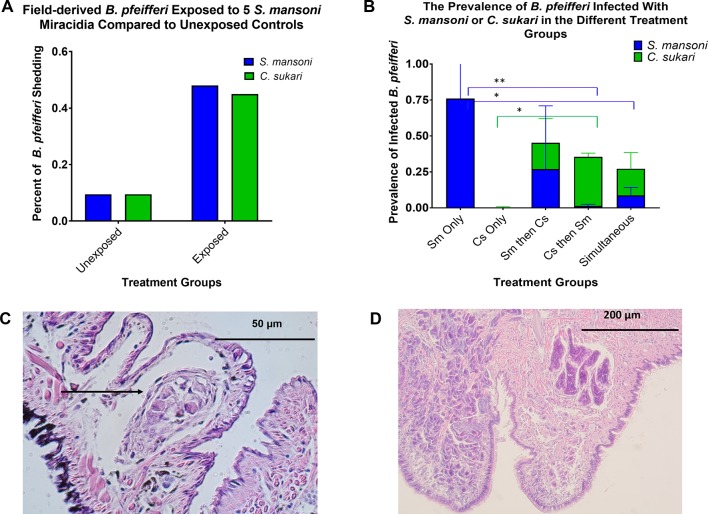
Human and cattle parasite interactions at Asao Stream.(A) Field-derived B. pfeifferi shown not to be shedding any cercariae at the time of collection were either left as unexposed controls or were exposed to S. mansoni (five miracidia/snail). Note that, unexpectedly, exposed snails were just as likely to subsequently shed C. sukari as S. mansoni cercariae compared to the control groups (p=<0.001). A few unexposed snails also shed cercariae, indicating that some of the snails had prepatent snails at the time of infection. (B) The prevalence of lab-reared B. pfeifferi exposed to various combinations of miracidia (see horizontal axis) of C. sukari and/or S. mansoni that subsequently shed cercariae of either species. Exposures to either species were with five miracidia/snail, 50 or 60 snails were used for each of 5 treatments for three separate experiments (total of 850 snails used). Separate ANOVAs were done for S. mansoni and C. sukari (each involving comparison of four groups), followed by pairwise comparisons. (C) Histological section of B. pfeifferi exposed to C. sukari for 8 days. Note the undeveloped sporocyst and the layer of hemocytes around it. (D) Histological section of B. pfeifferi exposed to S. mansoni for 8 days. The sporocyst has grown considerably and has developing daughter sporocysts within.